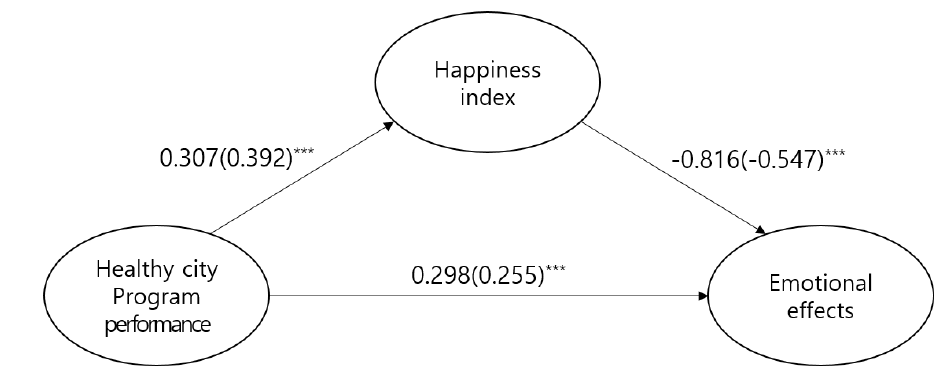
Figure 1. Research model path coefficients. Note: *** p < 0.001. Figure 2. Research model path coefficients. Note: *** p <